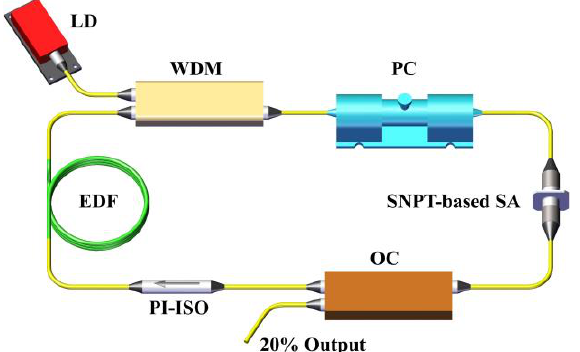
Figure 5. Setup of passively Q-switched fiber laser based on an SNPT-based SA. EDF: erbium-doped